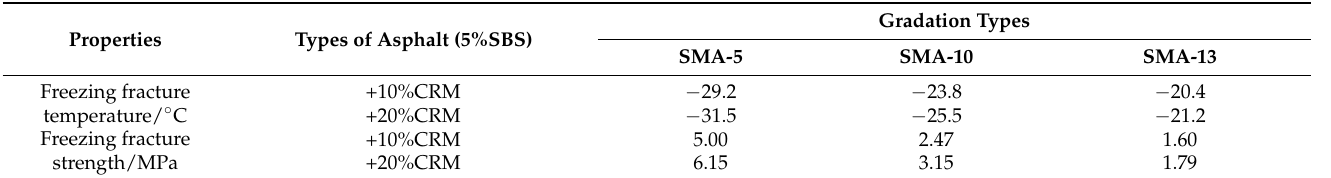
Table 9. Test results of asphalt mixture restraint specimens.